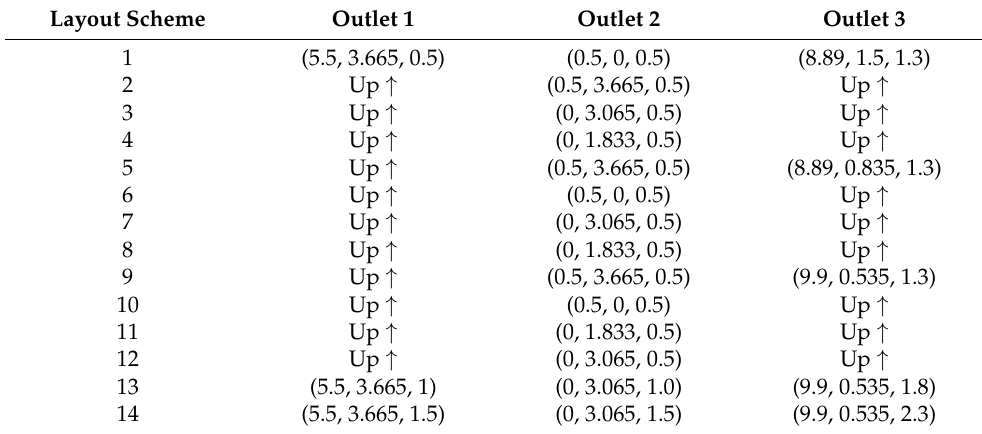
Figure 3. Grid independence test. The grid convergence index ( GCI ) was used to quantify the grid independence. Re- place Nos. 1, 2, 3, 4, and 5 with 1.09 million, 1.41 million, 1.91 million, 2.32 million, and 2.74 million, respectively. Grid convergence index ( GCI) is defined as [28]: 1 −= ps rFGCI ε